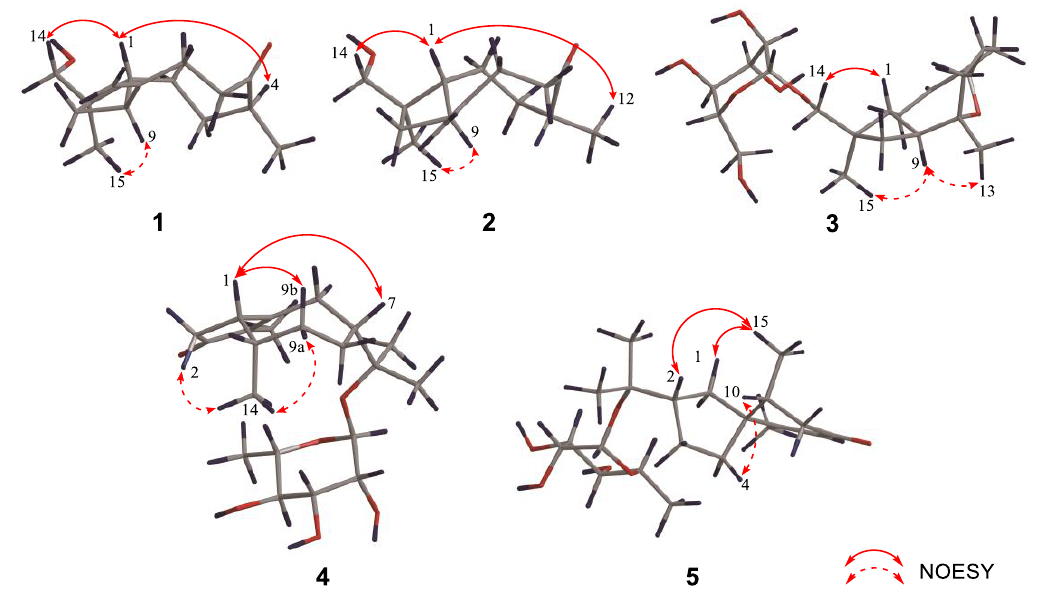
Figure 3. Key NOESY correlations of compounds 1 – 5 .